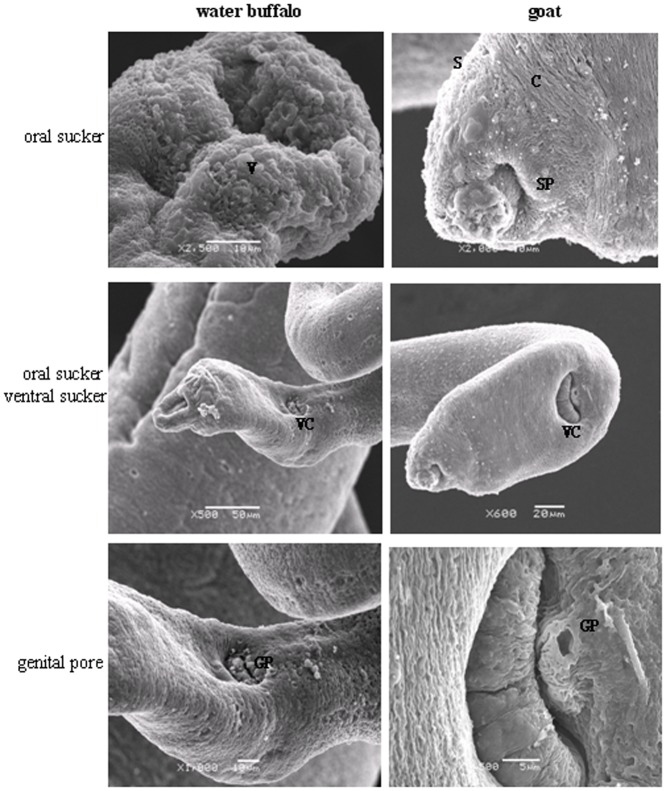
Comparisons of the oral suckers, ventral suckers, and the genital pores of female worms derived from water buffalo and goats by SEM.V, vacuole; C, crest; S, spine; SP, sensory papillae; VC, ventral sucker; GP, genital pore.